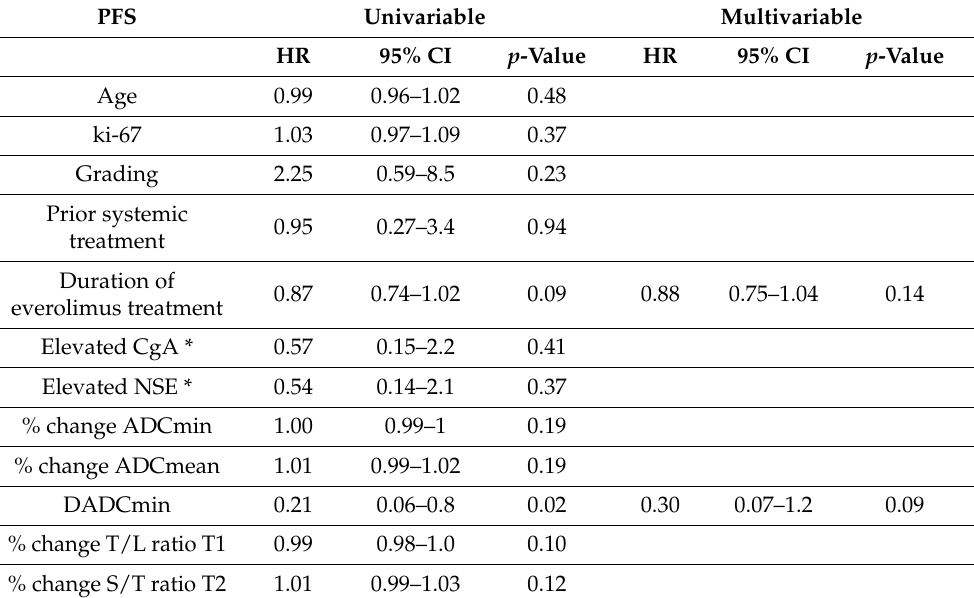
Table 2. Cox regression of PFS.